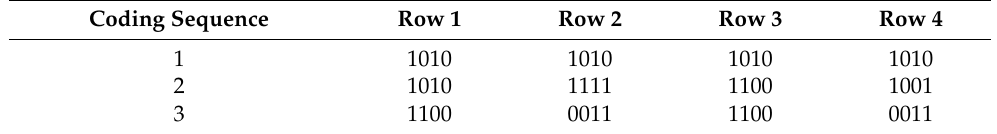
Table 6. Coding sequences of n = 4 for each